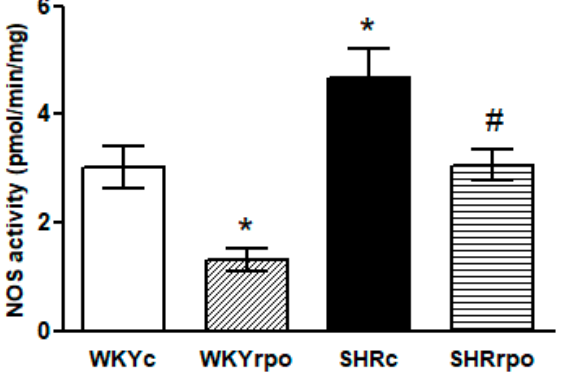
Figure 3. Effect of dietary red palm oil (RPO) on the nitric oxide synthase activity (NOS) in the left ventricle of normotensive and hypertensive rats. WKYc—Wistar Kyoto control rats; WKYrpo—WKY treated with RPO; SHRc—Spontaneously hypertensive rats; SHRrpo—SHR treated with RPO. Results are expressed as mean ± SEM; n = 5 in each group; * p < 0.05 versus control rats (WKYc); # p < 0.05 WKY/SHR versus treated with RPO.